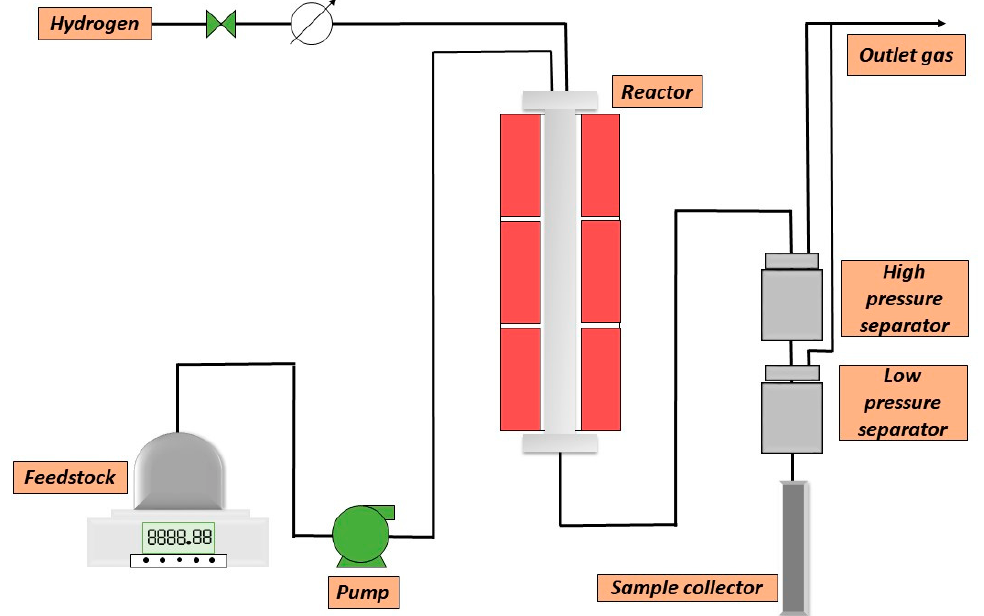
Figure 1. Schematic diagram of the testing unit (for one reactor).